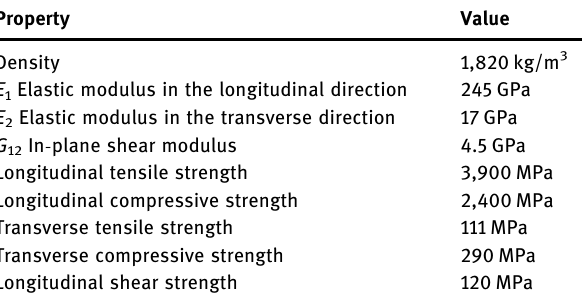
Table 3: Material properties of the CFRP sheet*